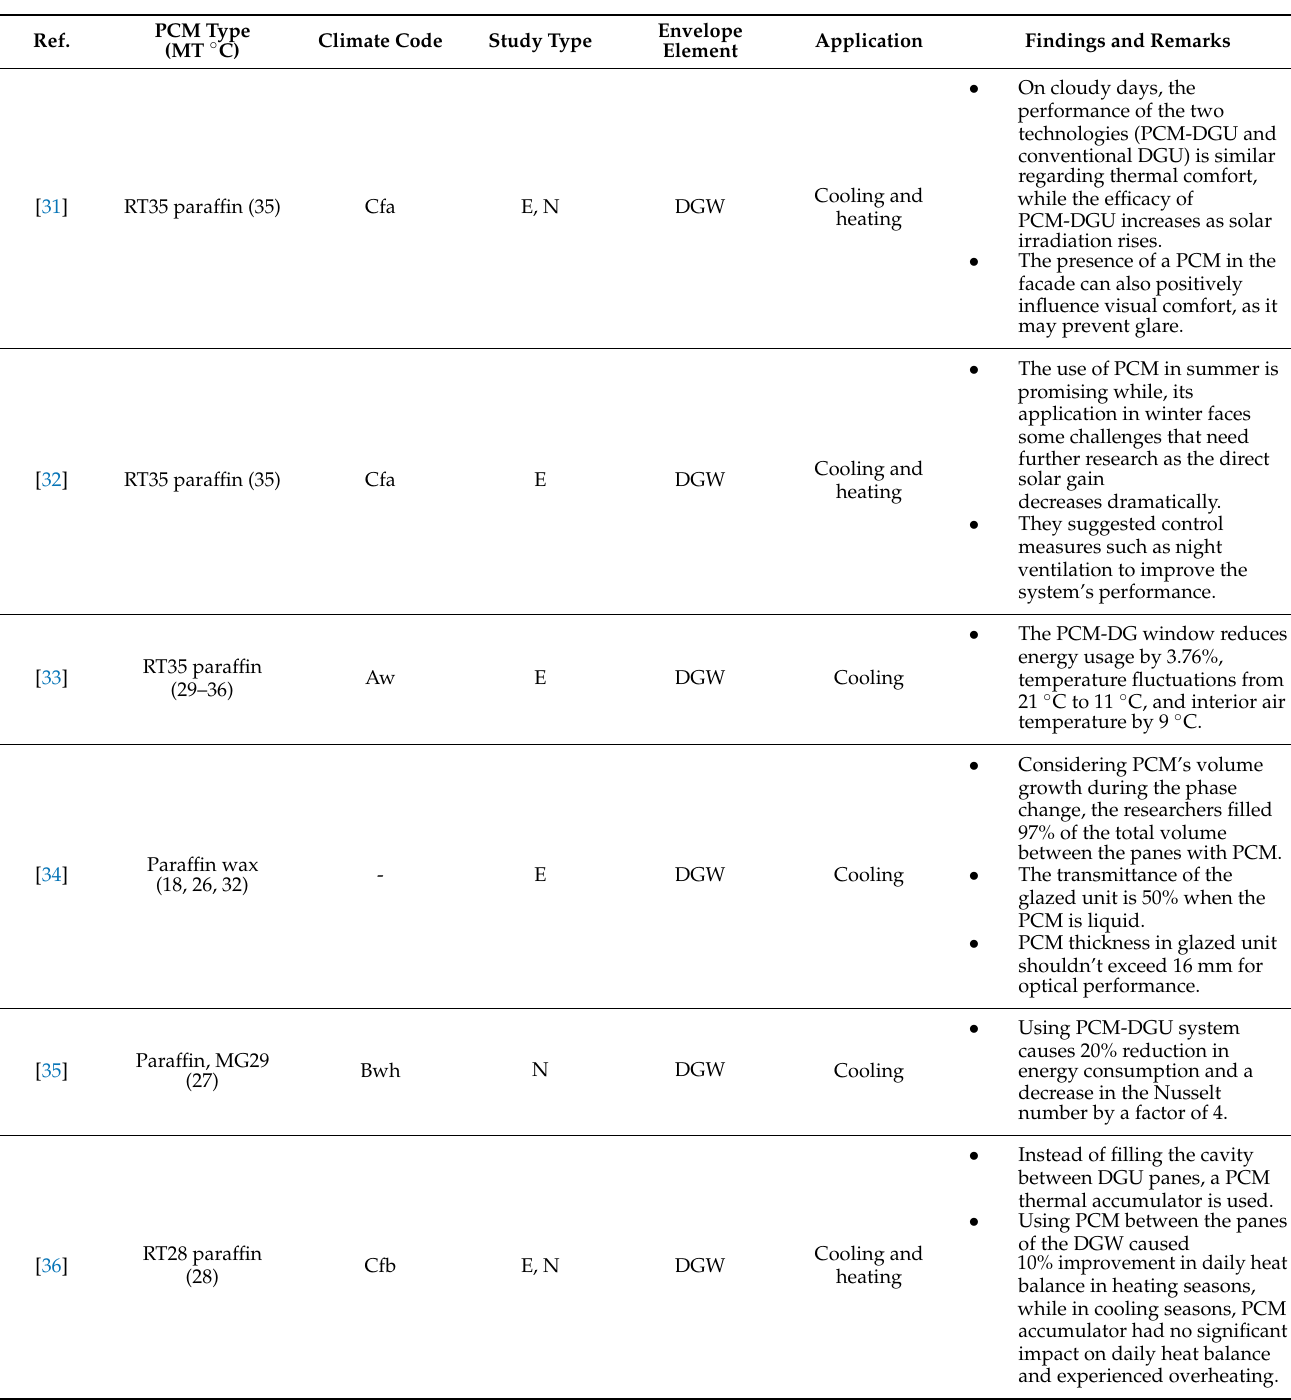
Table 3. Summary of PCM-incorporated multilayered